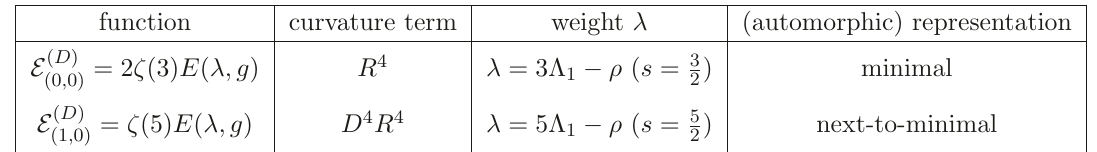
Table 1 . Table of curvature corrections at the two lowest non-trivial orders. The notation is explained in the text.